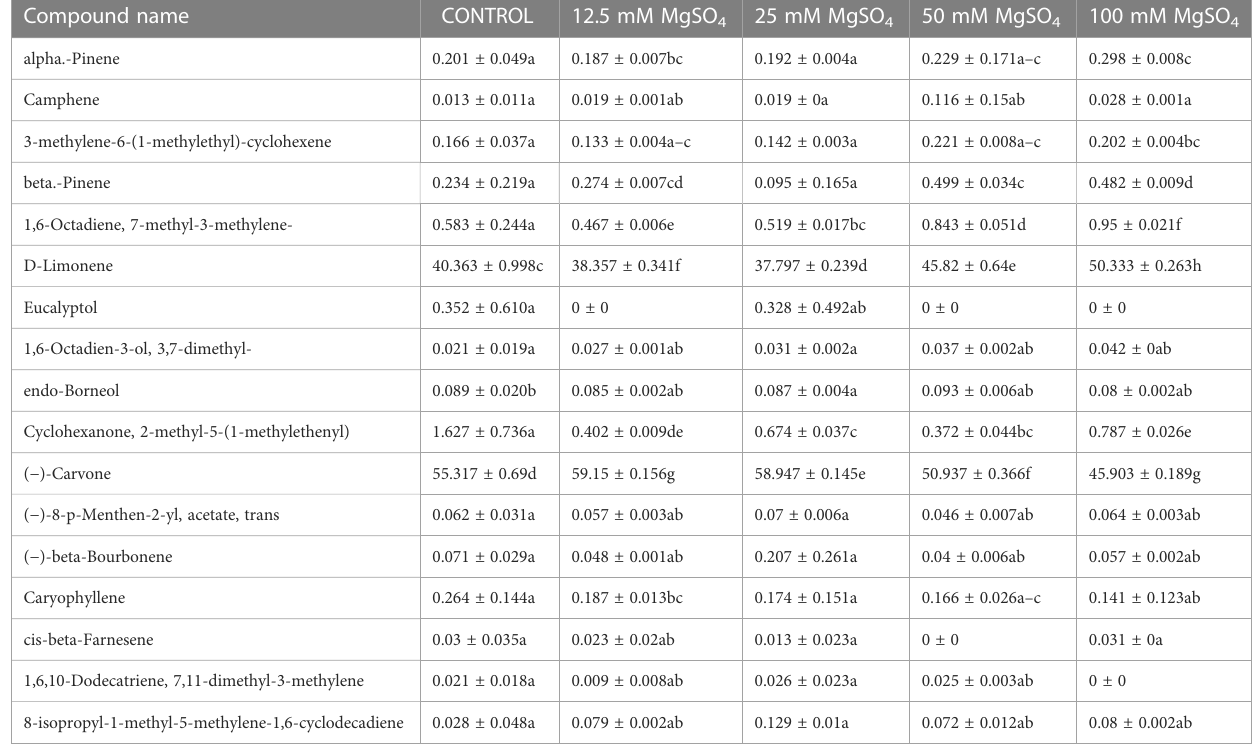
Means in the same column by the same letter are not signi fi cantly different to the test of Duncan ( a = 0.05).